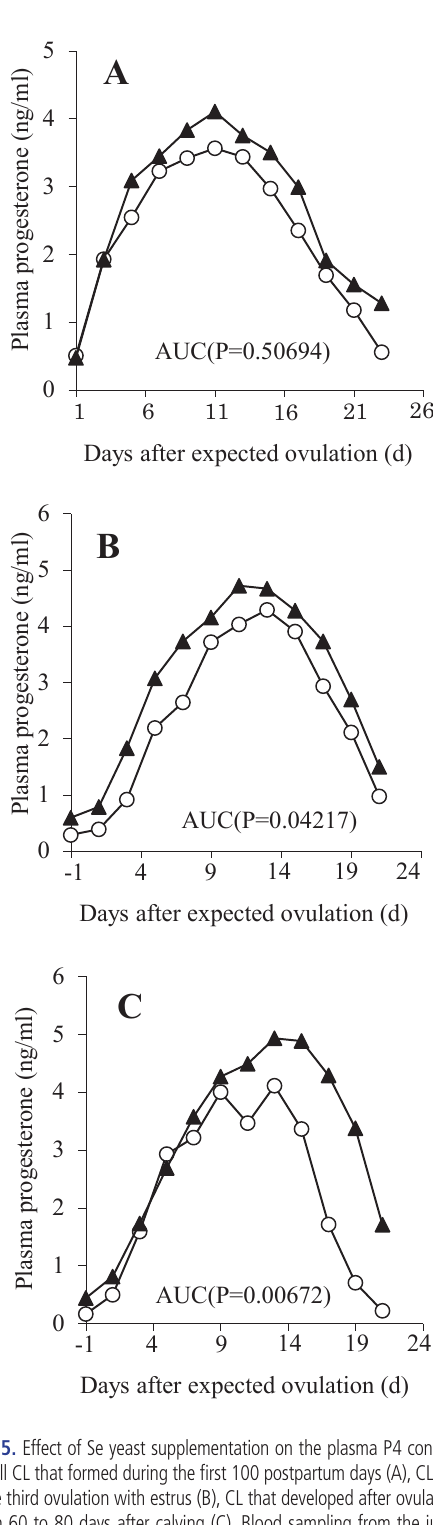
Figure 4. Effect of Se yeast supplementation on the plasma P4 concentration during the first 100 postpartum days (mean±standard error of the mean; -Se: n = 17, +Se: n = 17). Blood sampling from the jugular vein was carried out in the morning every two days. Plasma P4 concentrations were measured using an enzyme immunoassay kit after diethylether extraction. All assays were performed in duplicate. Significant difference according to the Bonferroni method was defined as a p value of <0.05 (*) and <0.07 (†).